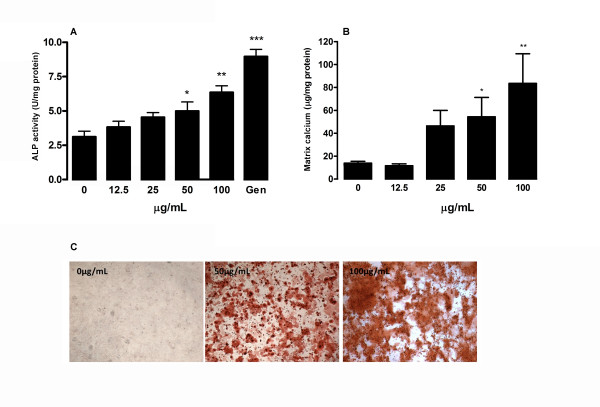
Osteogenic properties of FLL aqueous extract in rat MSCs. Dose effect of FLL aqueous extract on (A) alkaline phosphatase (ALP) activity and (B) extracellular matrix content in MSCs were determined under osteogenic induction on day 7 and day 14 respectively. Data are the mean ± SD (n = 3) from three independent experiments. Significant difference: * P < 0.05; ** P < 0.01; *** P < 0.001 for difference from respective baseline cultures without treatment. (C) Calcium deposition at different treatment concentrations (0, 50 and 100 μg/mL) was visualized by Alizarin Red S staining on day 14.